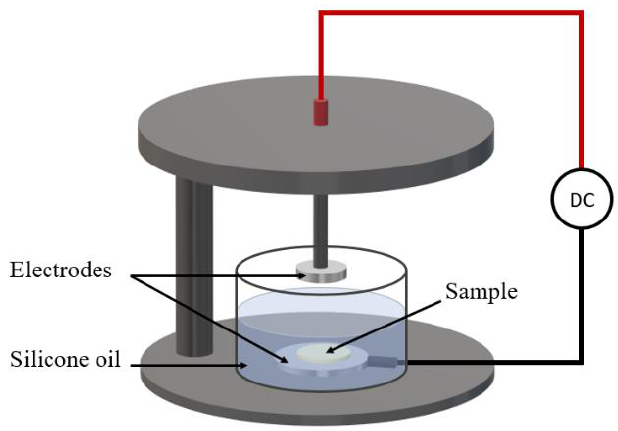
Figure 15 . Illustration of the poling setup.